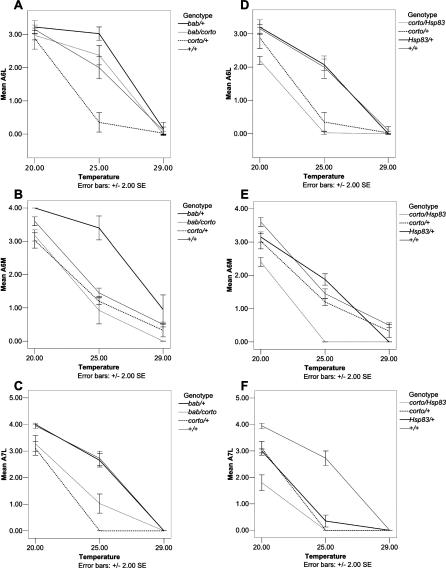
Temperature Interacts with a Network of Regulatory Factors and the Chaperone Hsp90 for the Regulation of Melanin ProductionShows the effect of variation of temperature and the alleles babAR07 and corto420 (A–C) and corto420 and Hsp83e6D (D–F) on melanin production in the lateral region of A6 (A and D), the median region of A6 (B and E), and the lateral region of A7 (C and F).